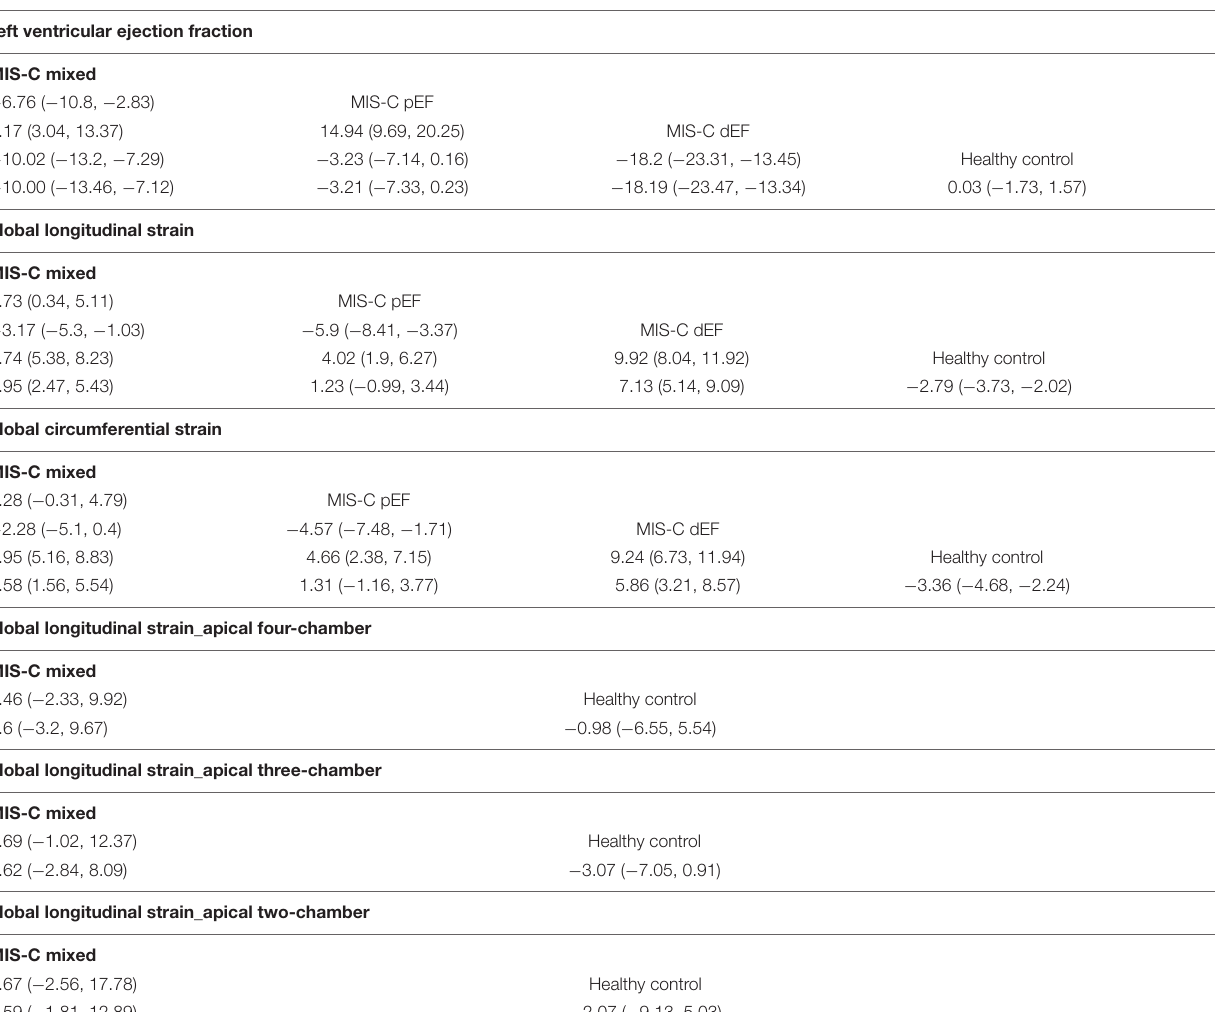
TABLE 2 | Head-to-head comparisons of left ventricular ejection fraction and global myocardial